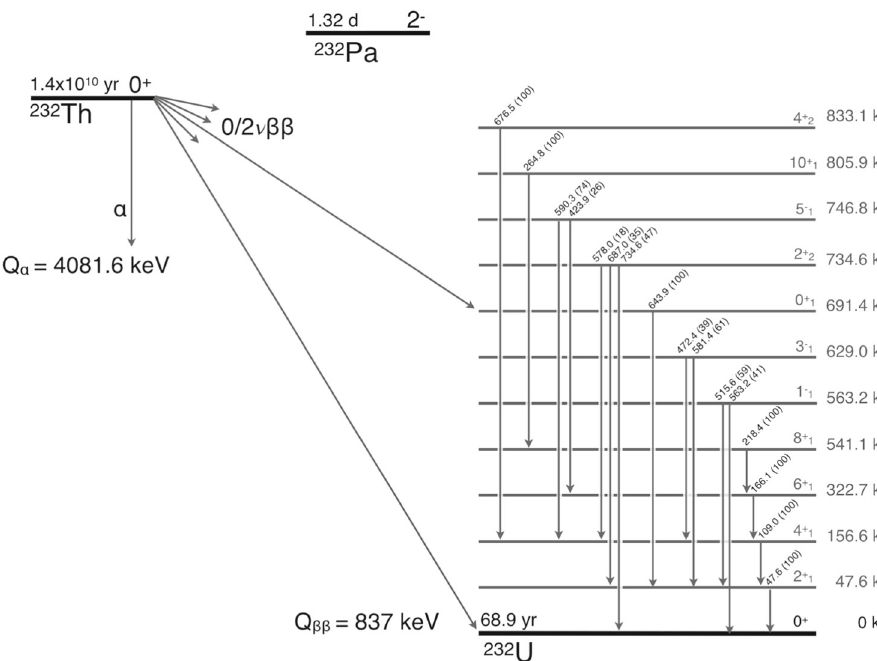
133 Ba and 60 Co sources. The energy resolution function